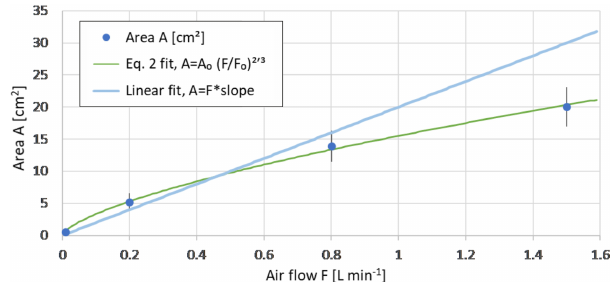
Figure 3. Bubble foam area vs flow rate, fit of Eq. (2). Mean foam area calculated from MQ and NaCl-solutions observations at + 21 ◦ C. The green line shows the fit of Eq. (2), and the light blue line shows the linear fit to the mean foam area A . Error bars show standard deviation.